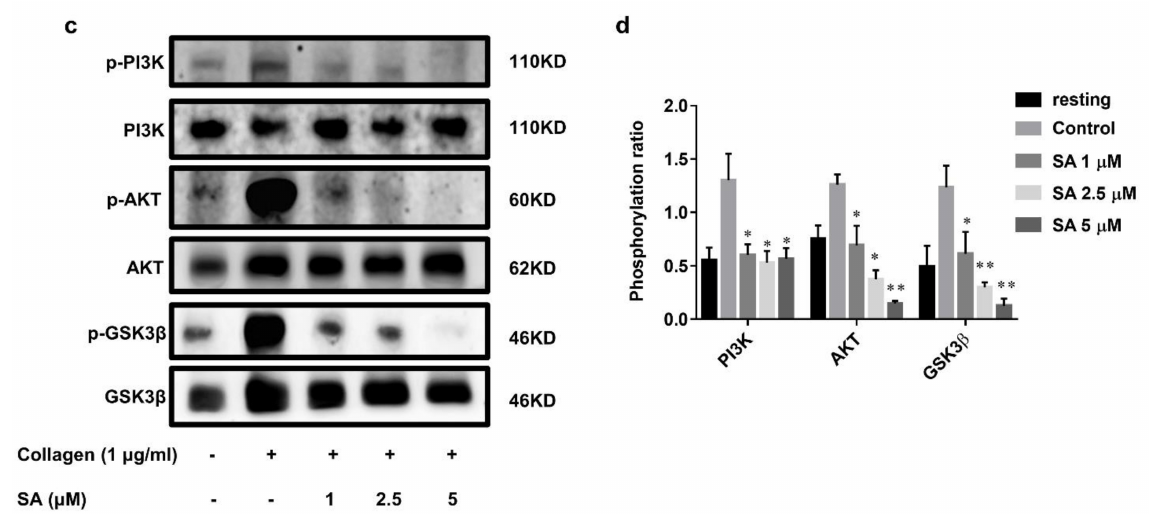
Figure 5. Sanguinarine has an inhibitory effect on collagen-induced phosphorylation of the signaling cascade. ( a , c ) Washed human platelets were treated initially with sanguinarine (1, 2.5, 5 µ M) or DMSO (control) at 37 ◦ C for 10 min, then stimulated with collagen (1 µ g/mL) for 5 min, and later underwent lysis with lysis buffer, followed by Western blotting using specific antibodies. ( b , d ) The Syk/PLC γ 2 and PI3K/Akt/GSK3 β phosphorylation ratios were measured. The blot was a representative of three independent experiments that showed statistical significance at * p < 0.05 and ** p < 0.01 compared with the control group ( n = 5).